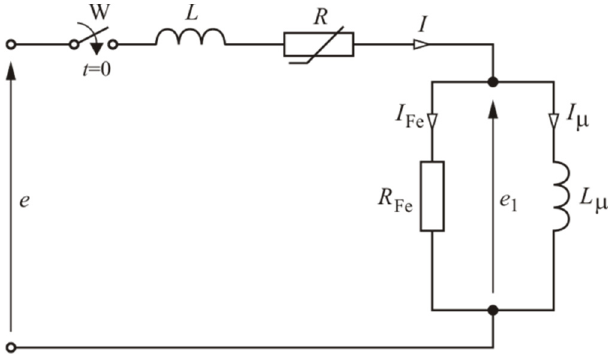
Figure 1. Scheme of a single-phase HTS transformer in the idle state.